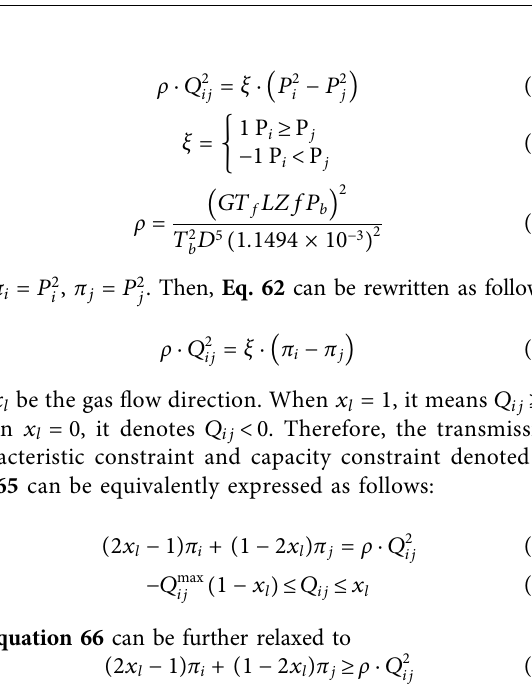
FIGURE 12 | Power output of each unit of case